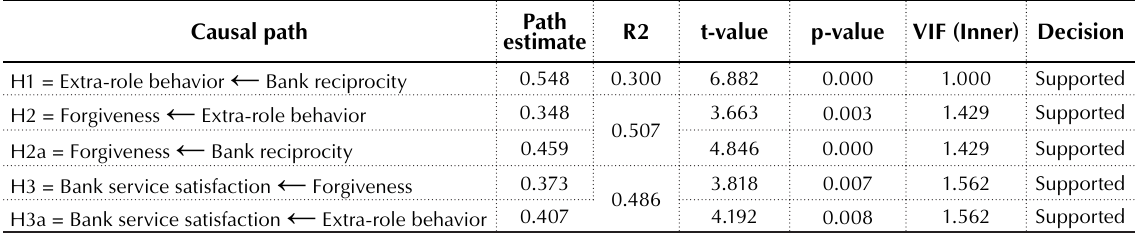
Table 3. Inner model